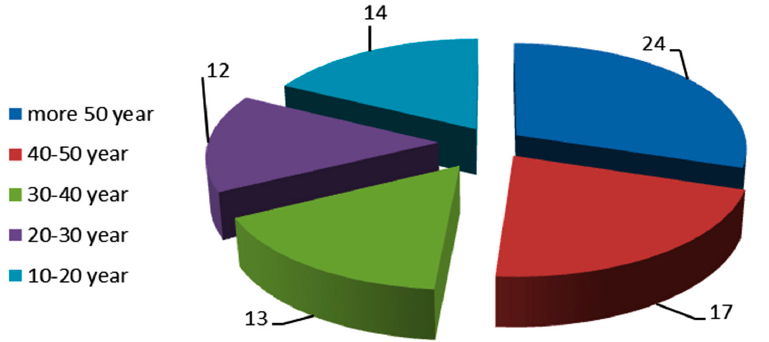
Fig. 1. Distribution of Streptococcus pneumonia isolates based on the seasonal infection in months